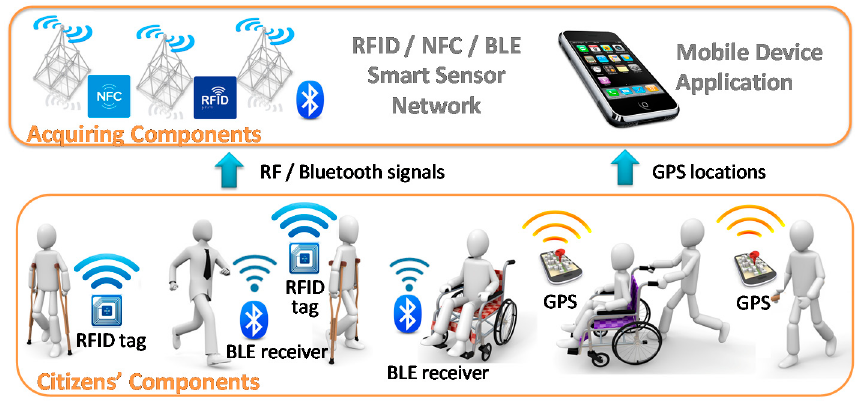
Figure 2. Acquisition infrastructure deployment.